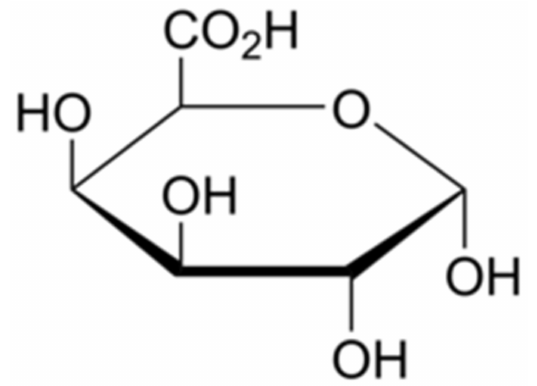
Figure 6. Chemical structure of D-galacturonic acid